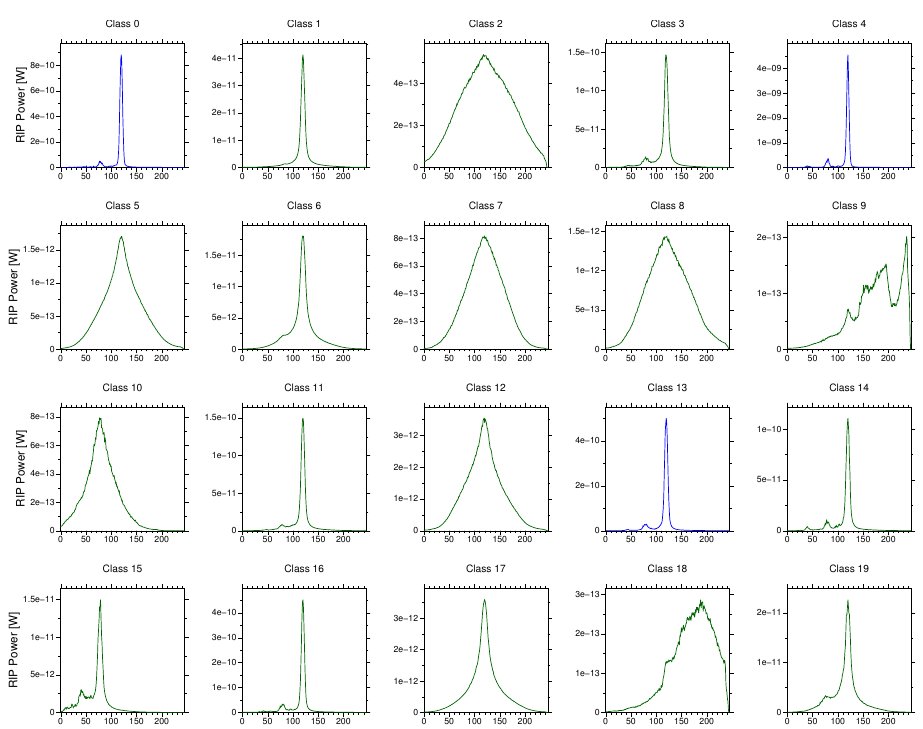
Figure A2. Upstream region mean RIPs. Water classes: 0, 4,